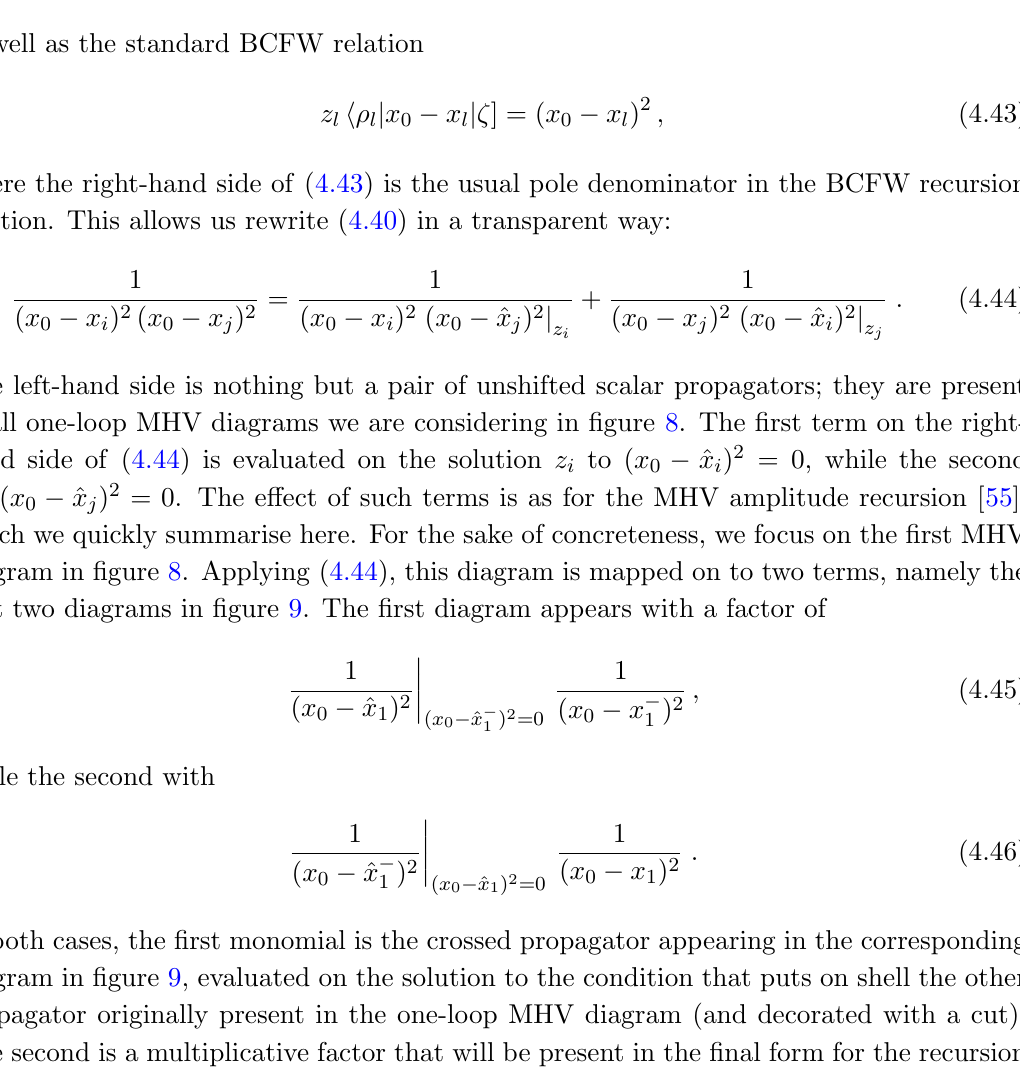
Figure 9. The single-cut diagrams contributing to the one-loop recursion. A red dotted line indi- cates a cut propagator, and a cross implies that the corresponding shifted propagator is evaluated on the solution to the cut of the other shifted